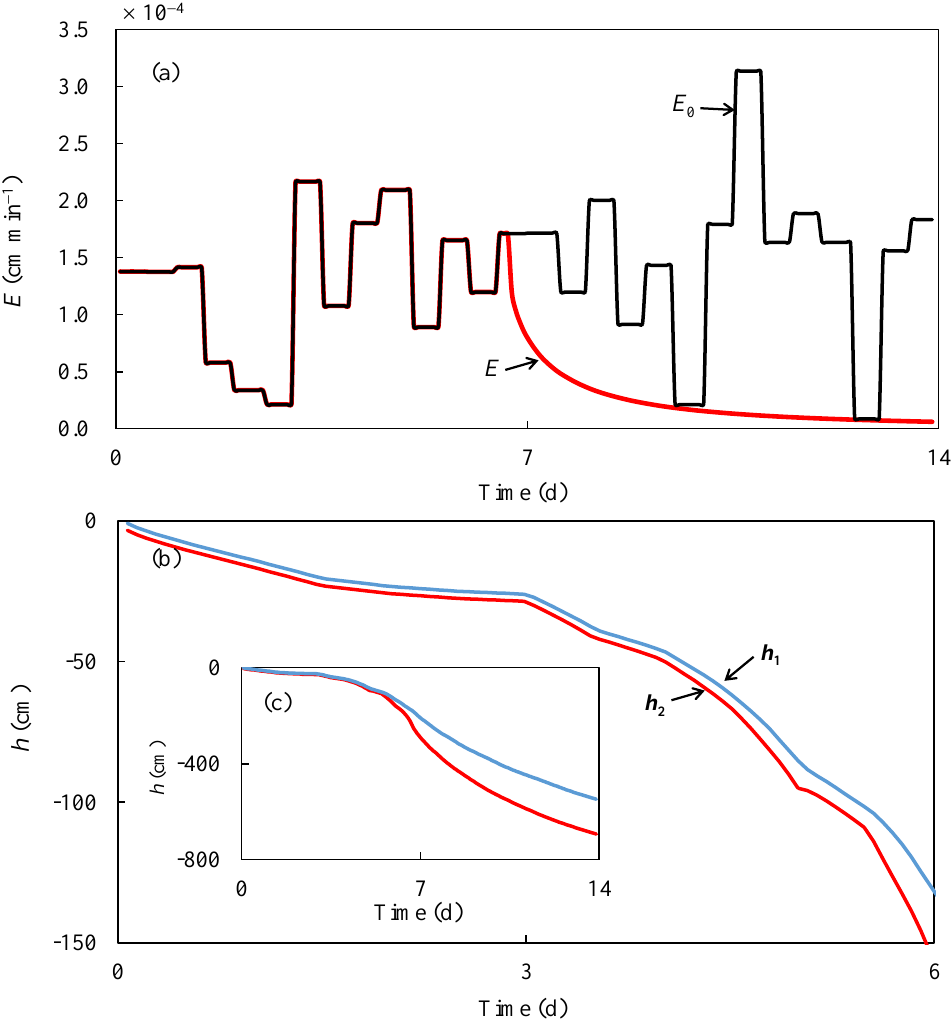
Figure 5. Synthetic experimental data for the loam example with a stochastic oscillation in the potential evaporation: ( a ) the change in the potential evaporation and simulated actual evaporation, ( b ) corresponding pressure heads in the first 8000 min period and ( c ) corresponding pressure heads during the entire experiment